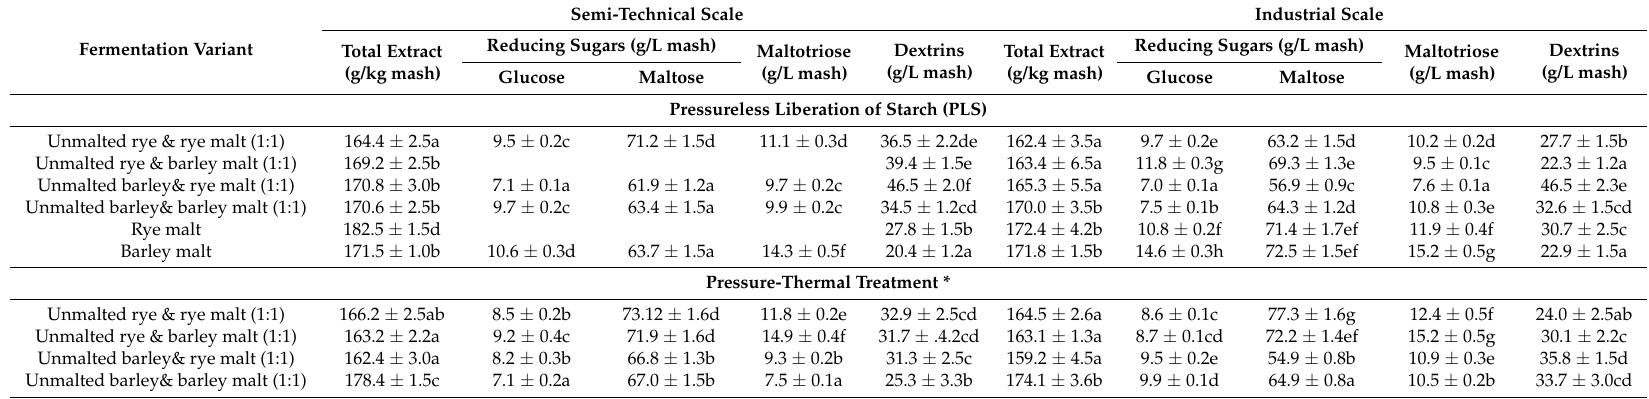
Table 3. Chemical composition of mashes prepared from unmalted cereal grains (rye and barley) and corresponding malts after fermentation.